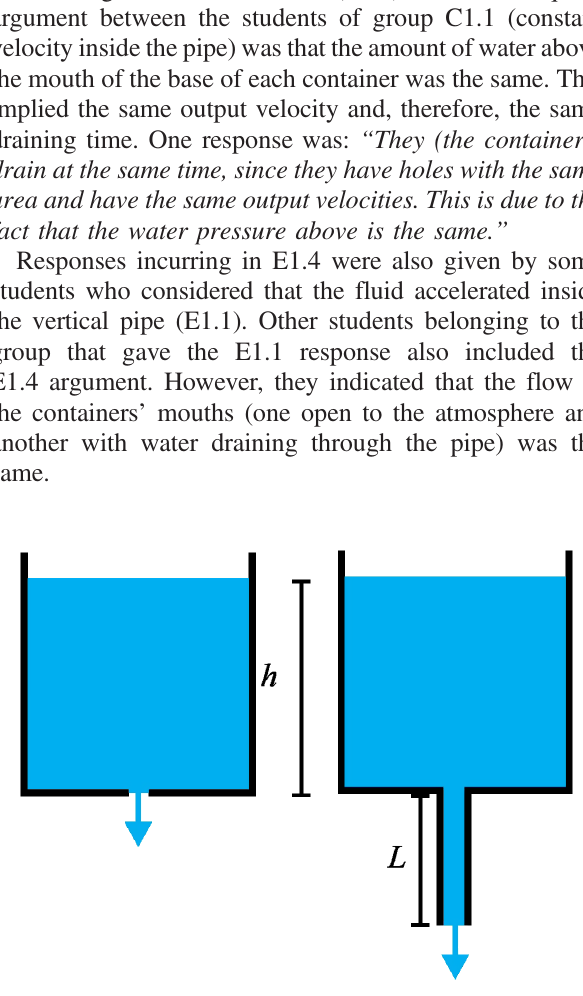
FIG. 8. Two similar open containers, one of them with a vertical draining pipe of length L . The initial water level is h in both containers.